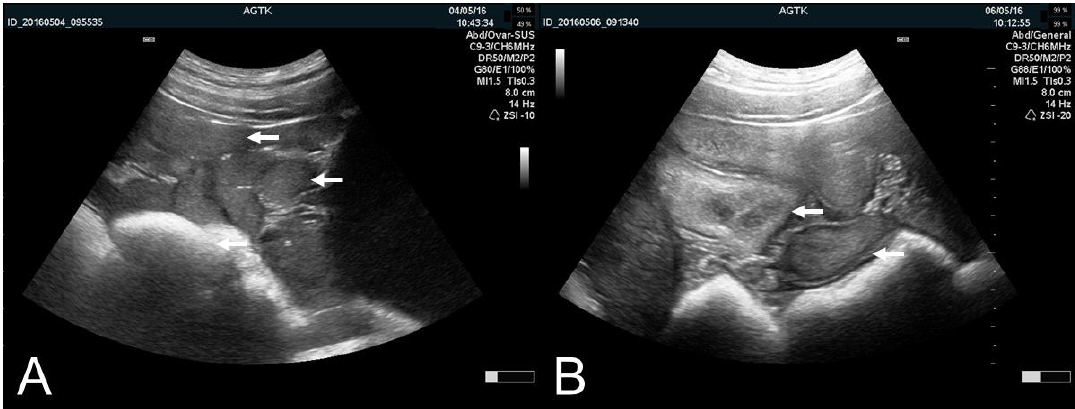
Figure 4. Transabdominal ultrasonographic images of uterine cross-sections (arrows) of sows in diestrus with a completely homogenous echotexture ( A ) and in estrus with a diffusely heterogeneous echotexture ( B ). Scale bar on right margin in 0.5 cm steps.